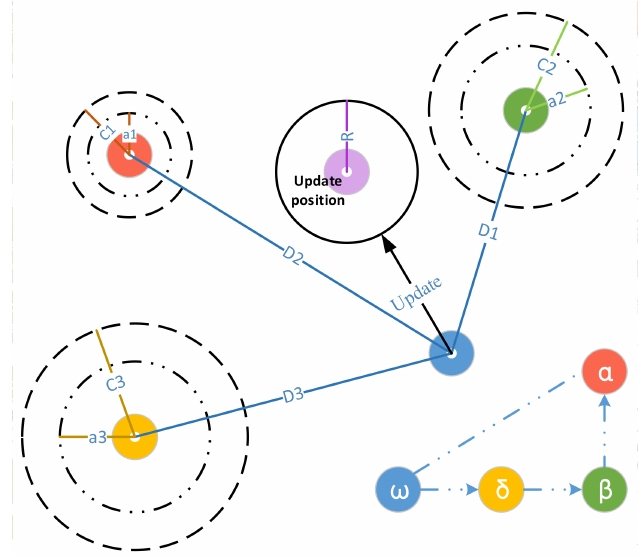
Figure 2. The process of GWO (Grey Wolf